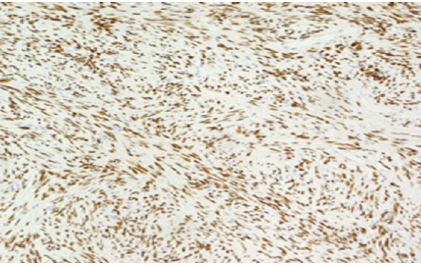
Figure 4: STAT6 IHC stain demonstrating strong di ff use positivity ( × 20 magni fi